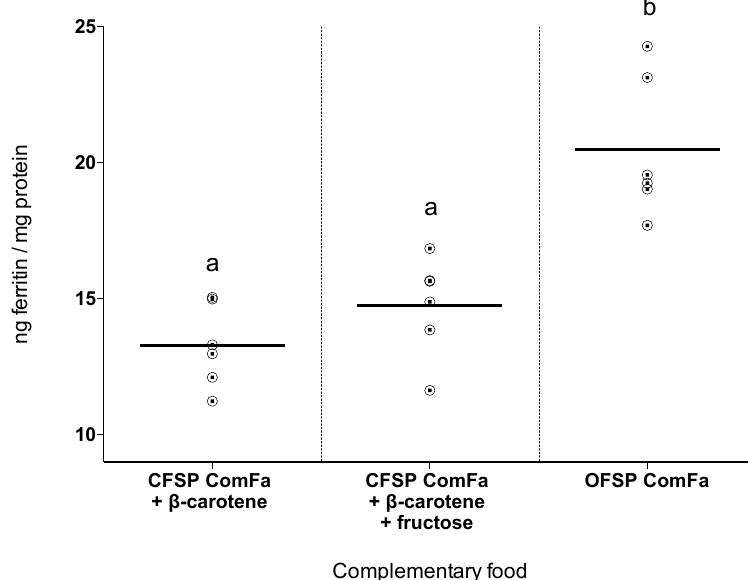
Figure 2. Ferritin formation per gram (adjusted for moisture content) of cream-fleshed sweet potato-based complementary food (CFSP ComFa) fortified with β-carotene, and β-carotene plus fructose, in comparison with orange-fleshed sweet potato-based food (OFSP ComFa). Ferritin formation was highest for Caco-2 cells exposed to OFSP ComFa; CFSP ComFa ferritin levels remained approximately 25% less than OFSP ComFa levels whether fortified with β-carotene alone, or β-carotene and fructose, and comparable to the CFSP ComFa ferritin concentration seen in Figure 1 (approximately 14 ng ferritin/mg protein). Plots are individual values that have been normalised to average blank ferritin levels ( n = 6); short horizontal lines indicate the group mean. OFSP ComFa mean ferritin formation (labeled b) was significantly higher ( p < 0.0001) than both other treatments (labeled